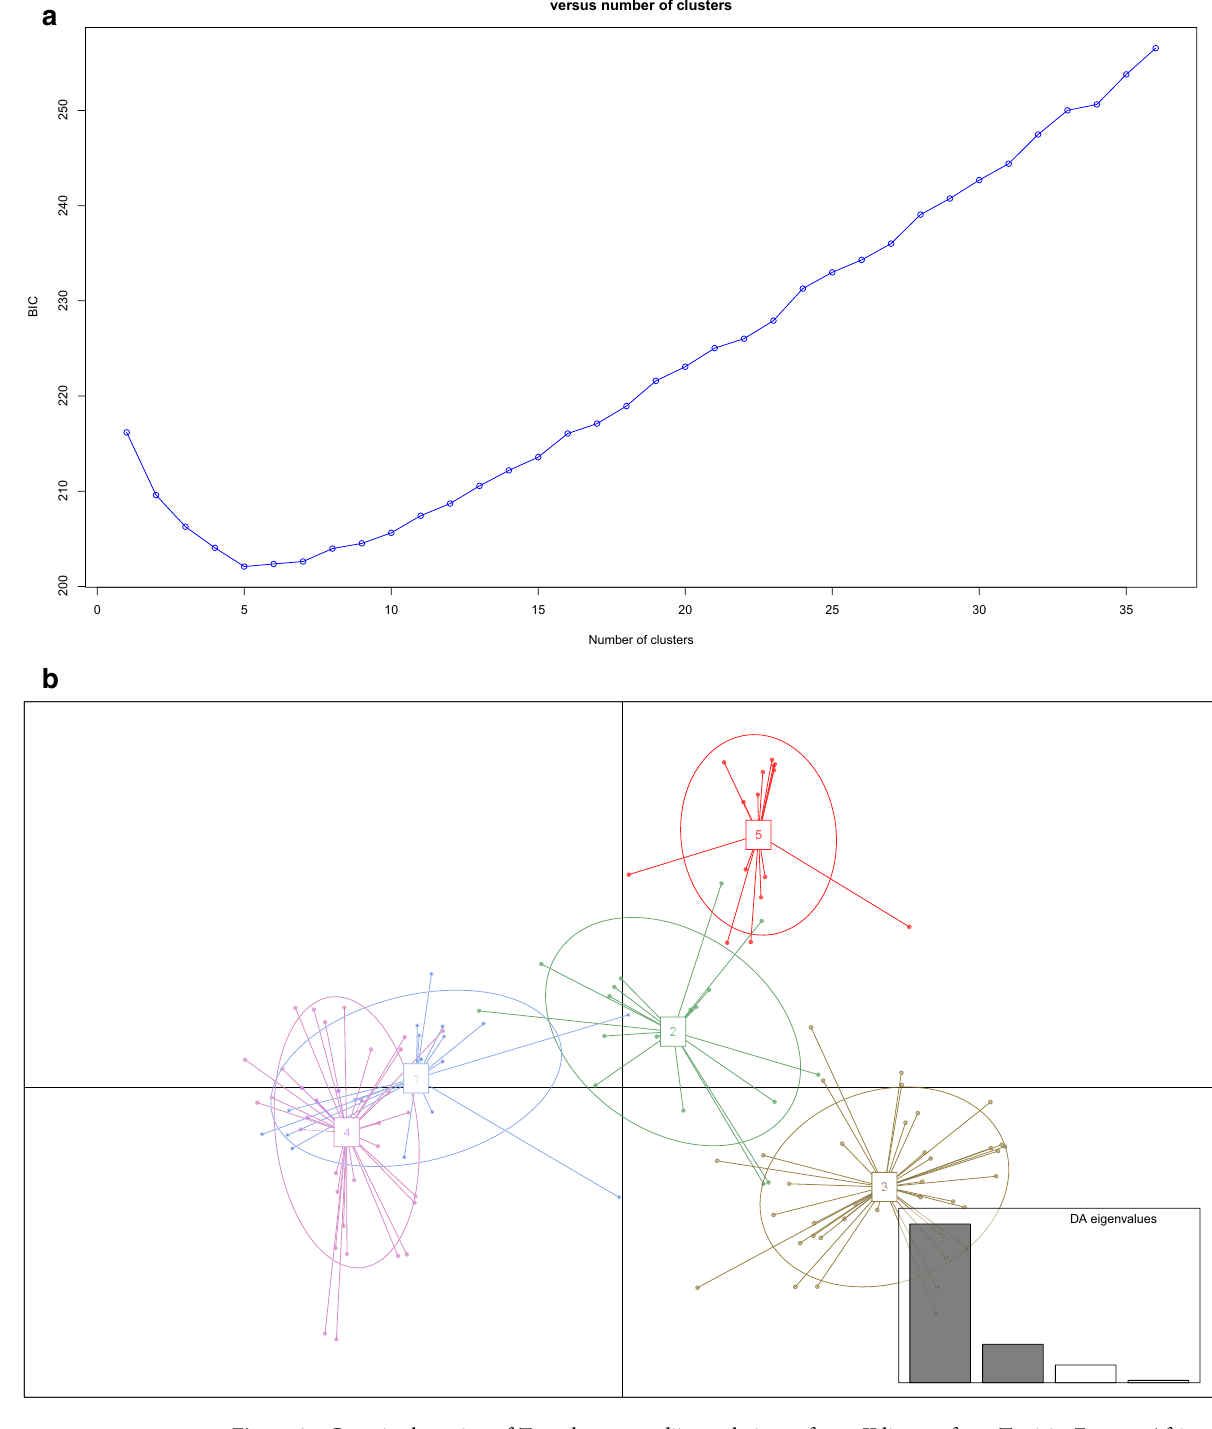
Figure 3. Genetic clustering of Toxoplasma gondii populations of type II lineage from Tunisia, Europe, Africa and Turkey utilizing the discriminant analysis of principal components (DAPC). ( a ) Bayesian information criterion (BIC) is provided for different numbers of clusters (from 1 to 35). ( b ) Scatterplot indicating axes 1 and 2 of the discriminant analysis of PCA-transformed data (DAPC). Individual clones are indicated by dots. Numbers and colours mention the five genetic clusters retained from Bayesian information criterion (BIC) values. ( c ) Barplots for the first two principal components of each individual estimated from DAPC. Individual strains are aligned along the x-axis and grouped according to the country of origin. Strains are assigned either to one cluster (each cluster is marked by a different colour) or to multiple clusters if their genotypes were admixed (indicated by multiple colours). The figures ( a )–( c ) were generated with the software RStudio 1.2.5042 (https:// rstud io. com/ produ cts/ rstud